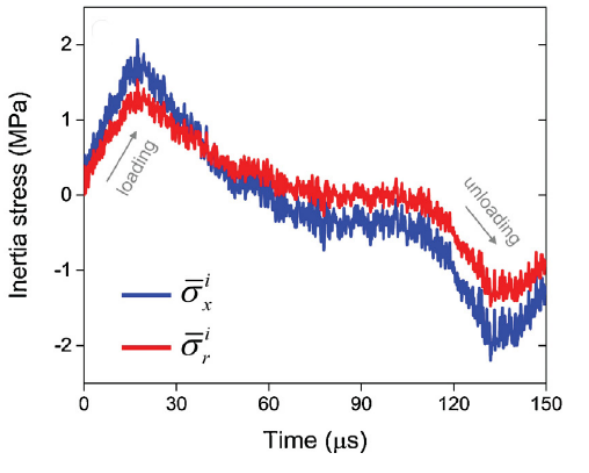
Figure 18. Axialand radial inertia stresses with respect to the deformation time. Strain rate data were extracted from a controlled impact test performed on a polymer foam in a Split-Hopkinson pressure bar. Compressive stress is positive